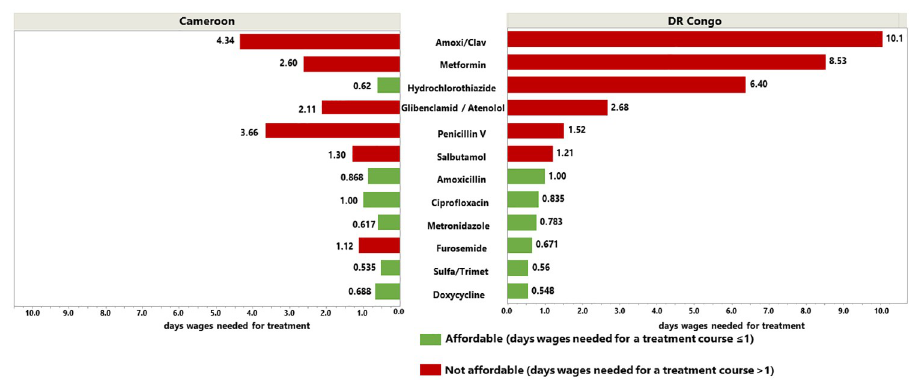
Fig 5. Median prices per treatment and median days’ wages needed for